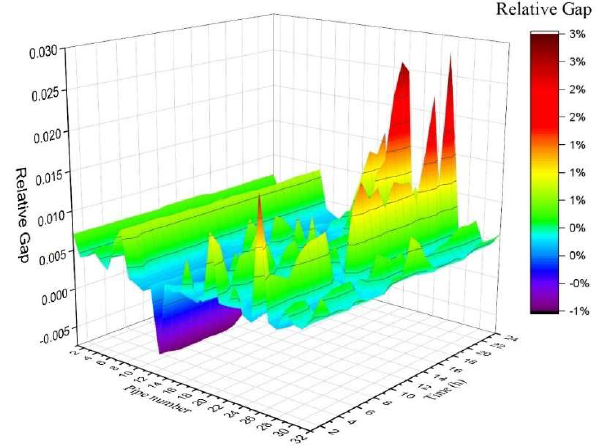
Figure 12. Comparison of heat loss along pipes between two models.